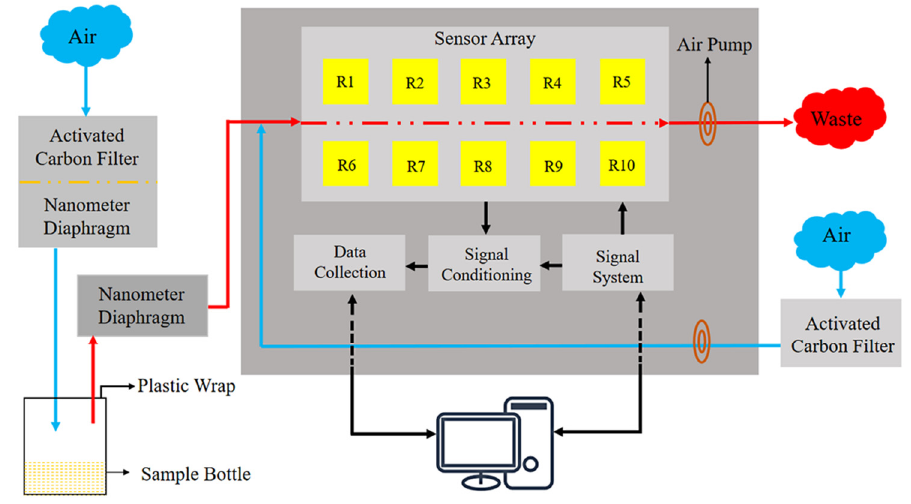
Figure 1. The test platform of the electronic nose (PEN3).